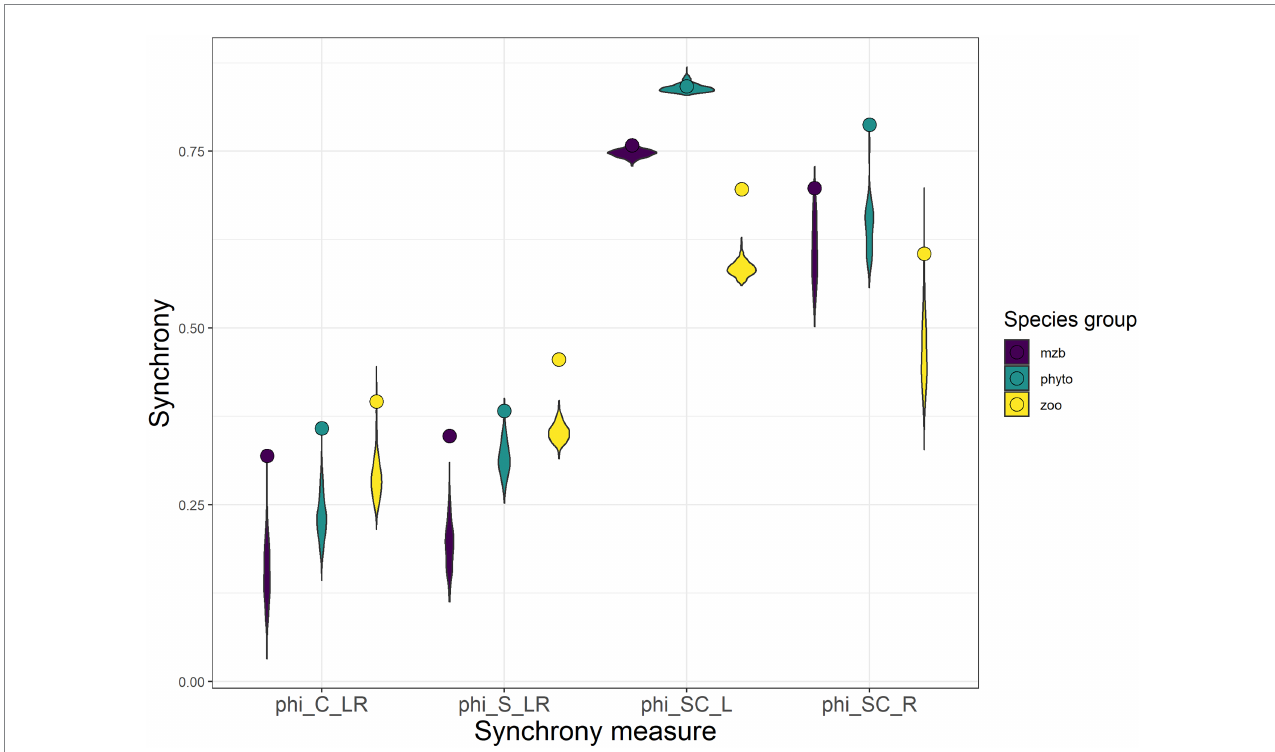
FIGURE 5 Four metrics of synchrony calculated between the different levels of spatial and ecological scale: the synchrony between local community biomass across space (phi C_LR ), the synchrony between populations of one species across space (phi S_LR ), the synchrony across species at one site (phi SC_L ), and the synchrony between aggregated (regional) species population biomasses (phi SC_R ). Violin plots indicate distributions of synchrony coefficients obtained from simulations of uncorrelated population and patch dynamics. The synchrony coefficients calculated from the three monitoring data sets are represented with round symbols. The Colors indicate the three organism types (purple—macrozoobenthos, green—phytoplankton, and